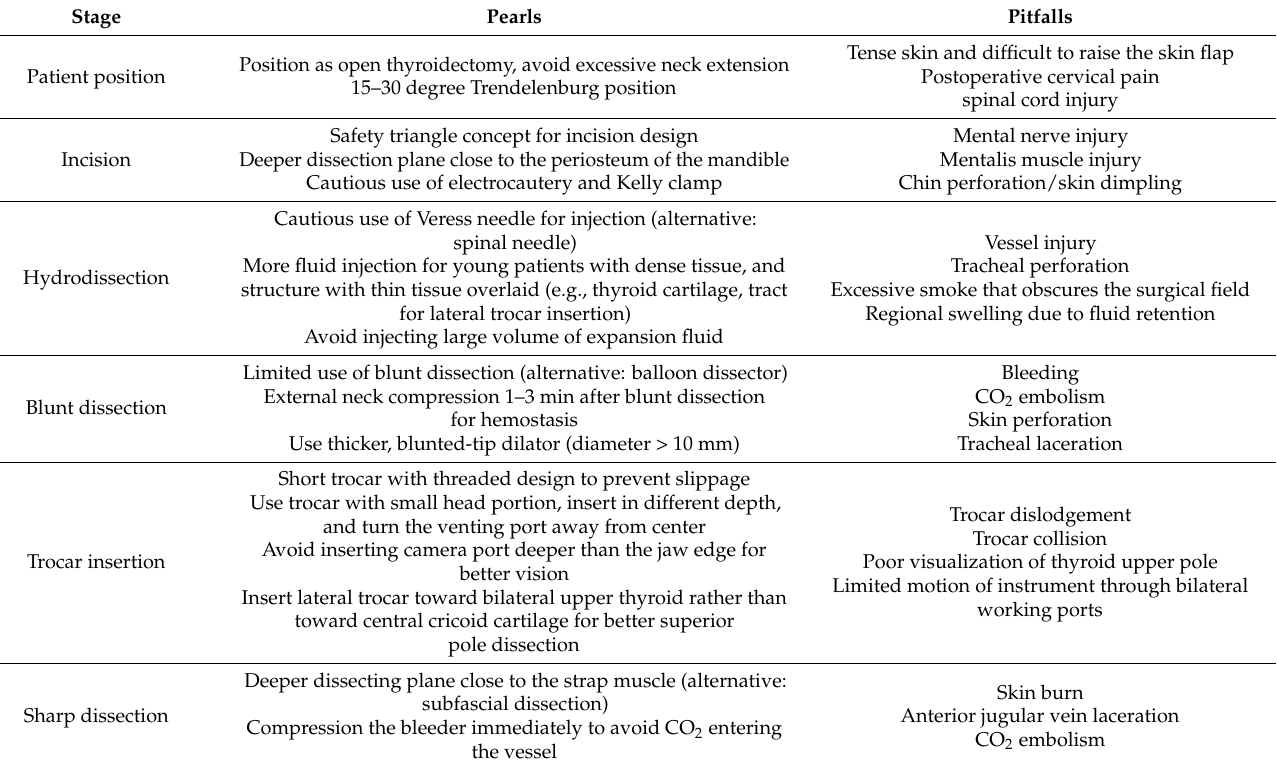
Table 1. A summary of key points for working space creation in transoral